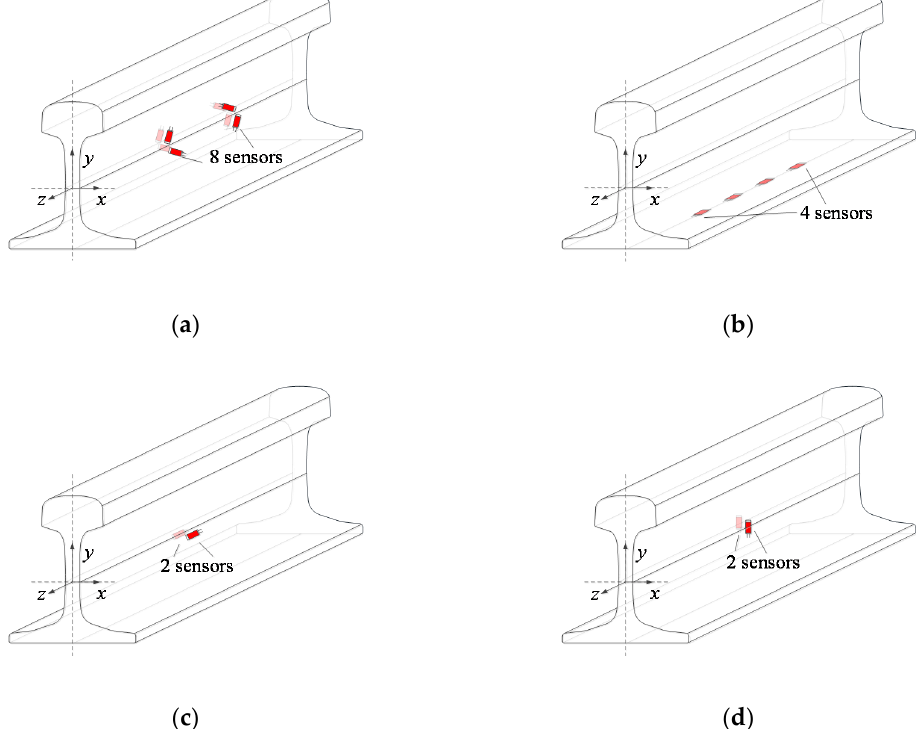
Figure 6. Commonly used wheel-rail force measurement methods: ( a ) Sheer force method; ( b ) rail base bending moment method; ( c ) rail web bending moment method; ( d ) rail web compression method.